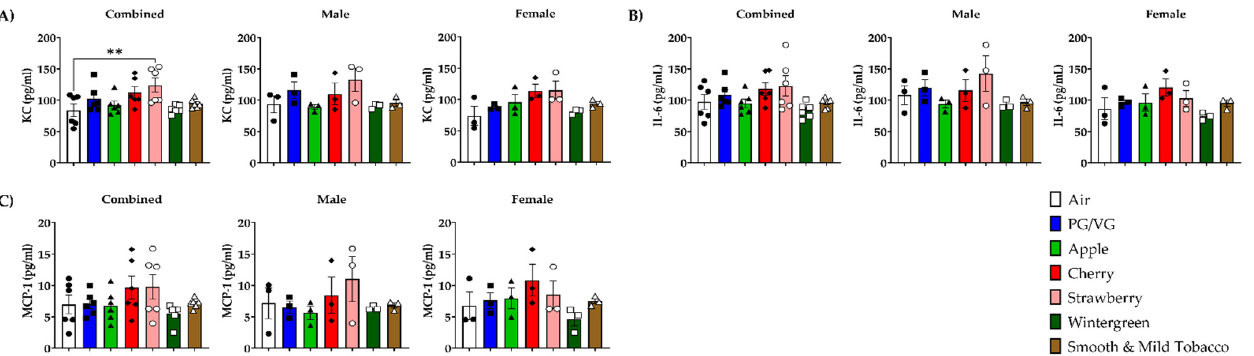
Figure 2. Sex-dependent effects of flavored e-cigarette exposure on pro-inflammatory cytokines/chemokine release in bronchoalveolar lavage fluid. Mice were exposed to air, PG/VG, and e-liquid flavors “Apple”, “Cherry”, “Strawberry”, “Wintergreen”, and “Smooth & Mild Tobacco” for 3 days for 1 h per day. Mice were sacrificed twenty-four hours after the final exposure. Pro-inflammatory cytokines/chemokines were measured in BALF. ( A ) KC levels, ( B ) IL-6 levels, ( C ) MCP-1 levels. Data are shown as mean ± SEM with individual data points represented by the following symbols: Air (black circles), PG/VG (black squares), Apple (black triangles), Cherry (black diamonds), Strawberry (white circles), Wintergreen (white squares), Smooth & Mild Tobacco (white triangles), with ** p < 0.01 vs. air controls. n = 6 for combined groups and n = 3 for male- and female-only groups.